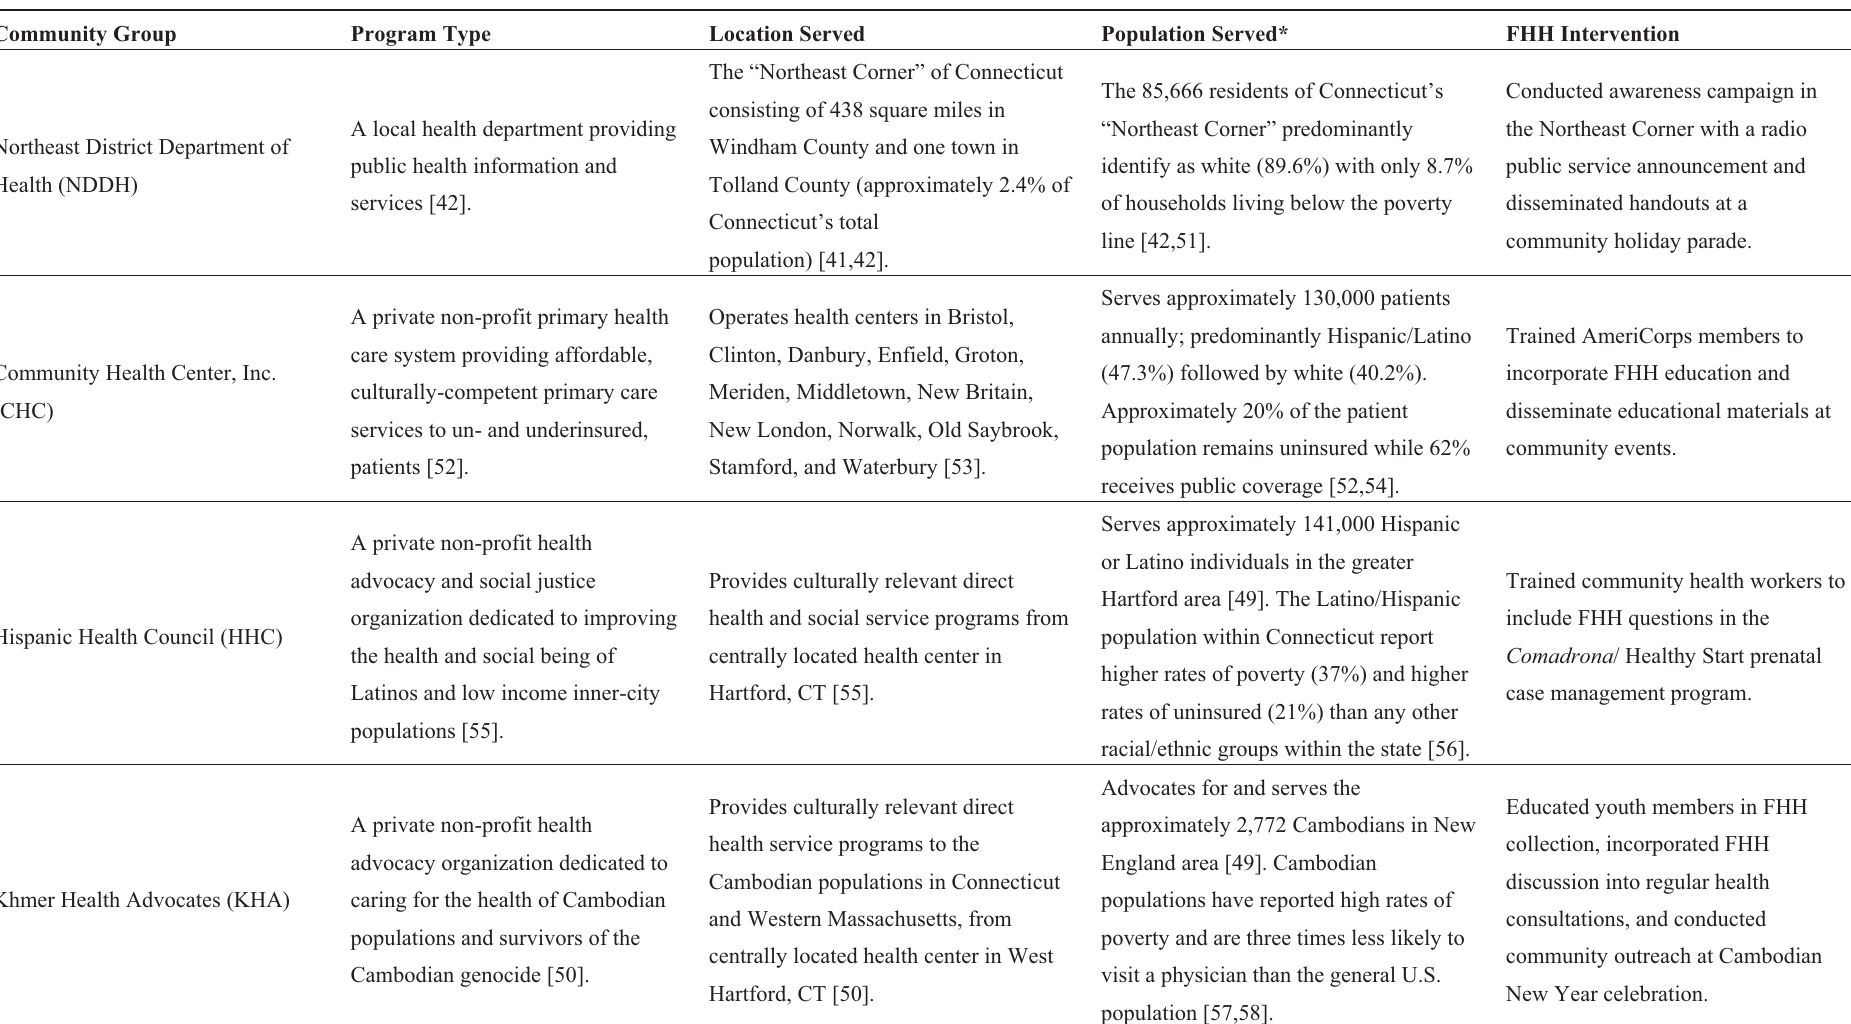
Table 1. Family health history (FHH) interventions completed by Connecticut community-based health